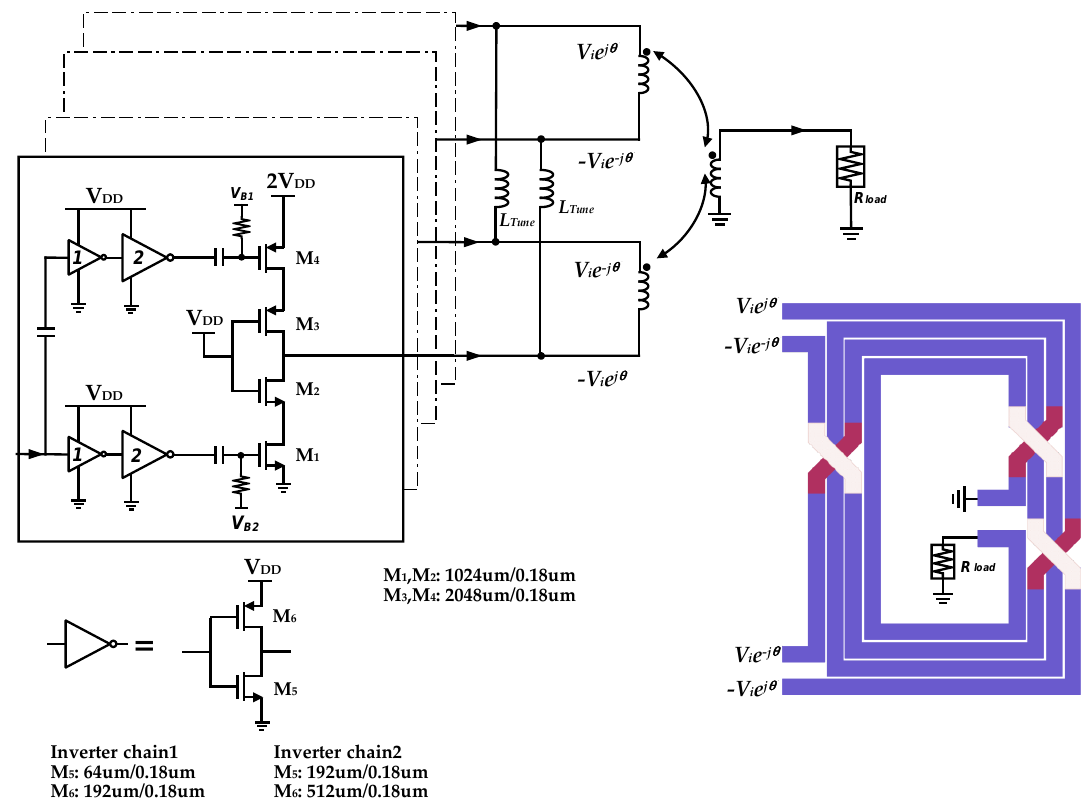
Figure 9. Schematic of the proposed outphasing PA using the parallel-combining transformer.